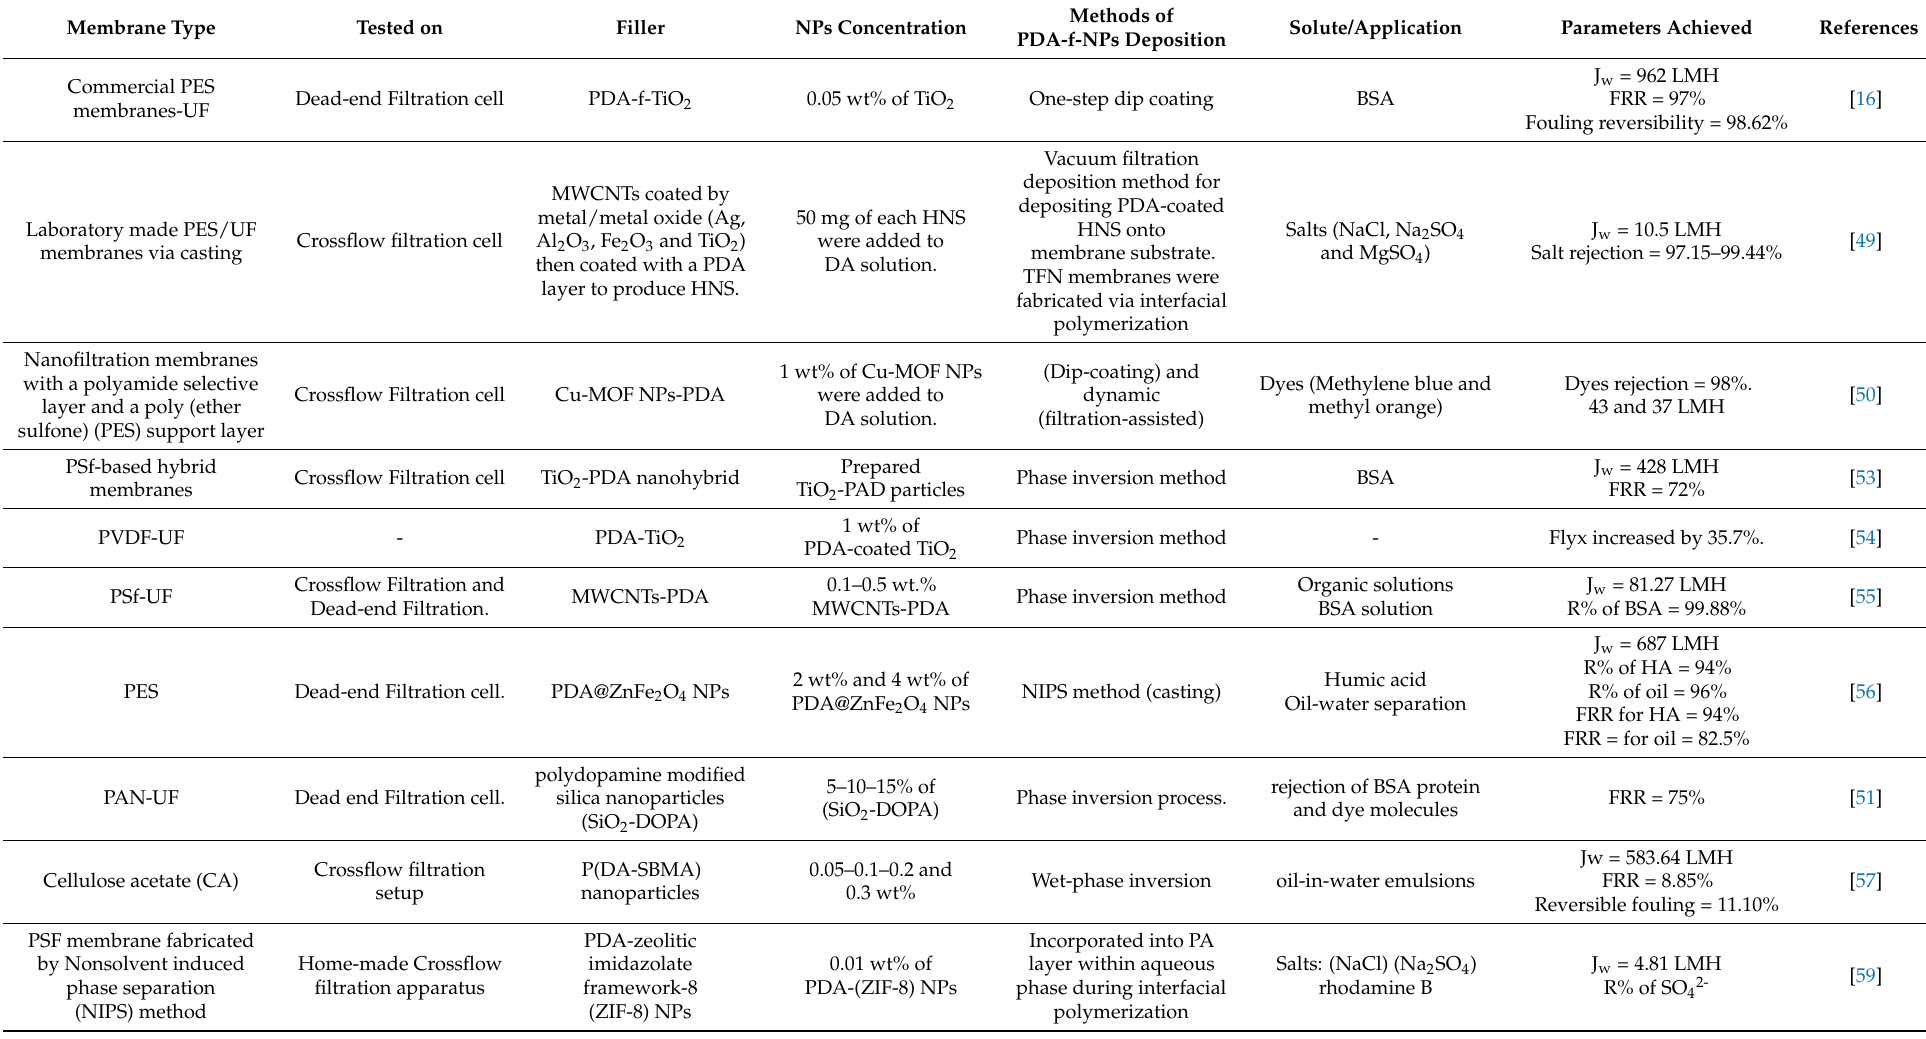
Table 2. Studies based on different modifications methods using PDA-f-NPs for UF and NF